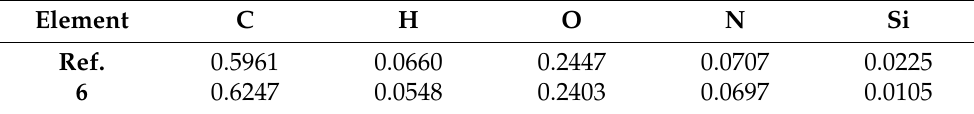
Table 8. Mass shares of individual elements in foams.